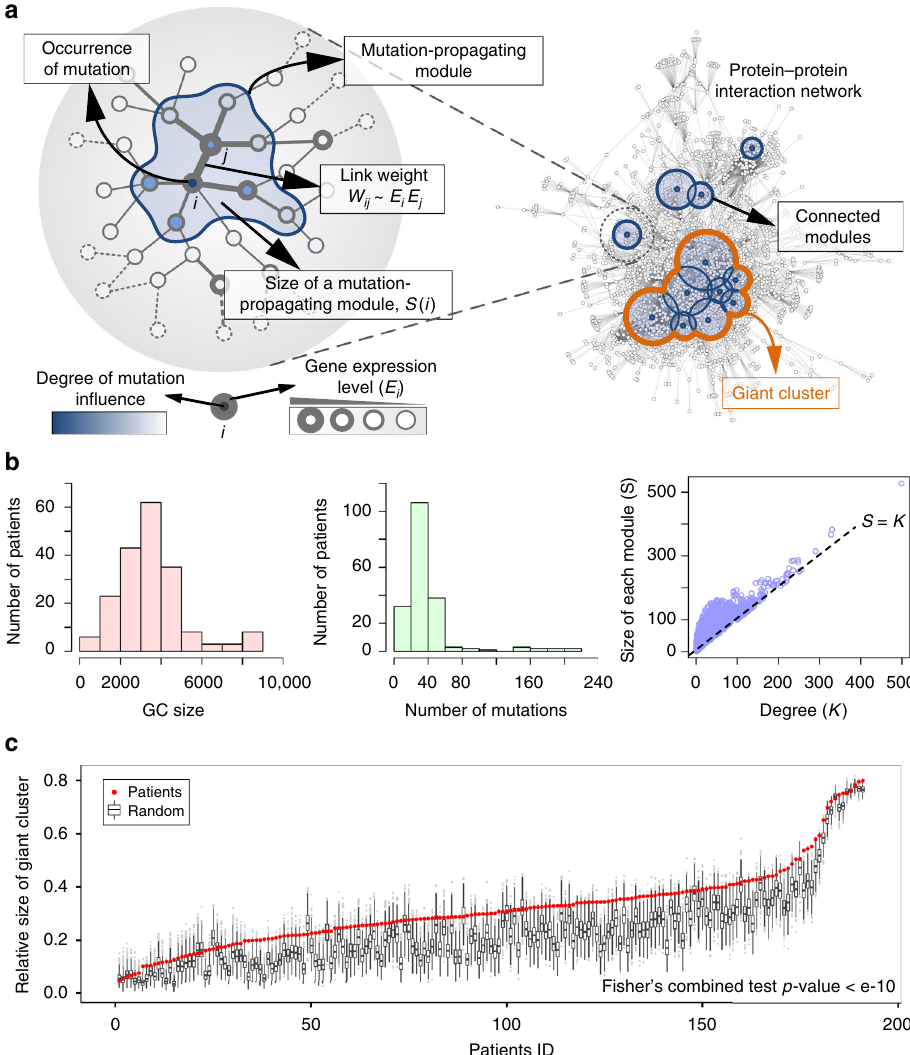
Fig. 1 The cooperative mutation effects represented by a giant cluster upon a PPI network. a Formation of a giant cluster upon a PPI network by the propagation of mutation in fl uences. A mutation in fl uence propagates along a PPI network and forms a mutation-propagating module, which is a sub- network that is effectively in fl uenced by the mutation. The link weight is determined by the product of the expression levels of its end genes, W ij (cid:1) E i E j . Several mutation-propagating modules occasionally form connected modules or a giant cluster, which is the largest connected module among them. The color intensity of nodes represents the degree of mutation in fl uence, and the width of a circle indicates the expression level of the corresponding gene. b Distribution of the size of GC (left) and the number of mutations (center) for 191 cancer patients. Right fi gure shows the size of each mutation- propagating module for all the mutated genes found in patients vs. the degree of each corresponding node for a threshold V = 0.001. c The size of GC normalized the network size for 191 patients compared to the random expectation ( n = 1000) where the same number of mutations for each patient was randomly